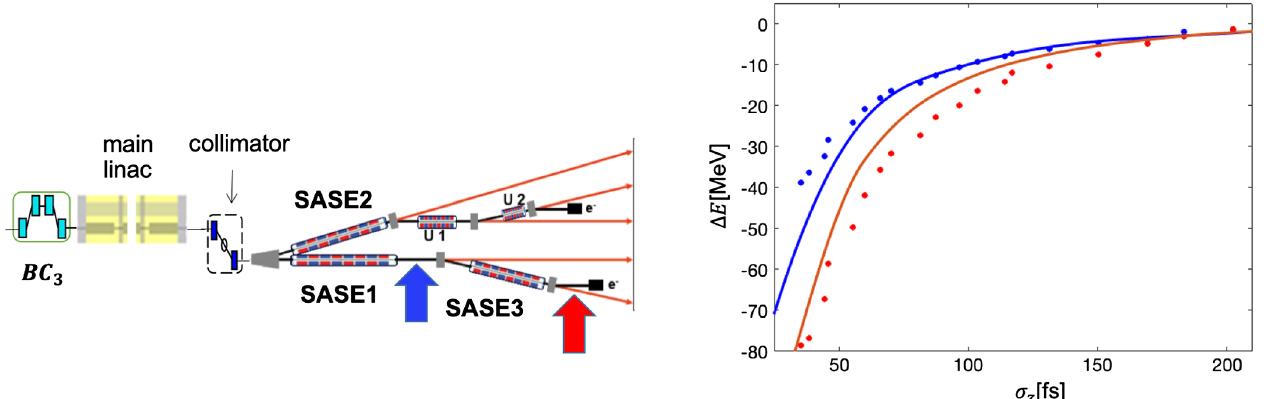
FIG. 15. Comparison of measurements and simulations. The energy loss was measured at two positions shown by arrows in the left plot. The right plot shows the energy loss of the beam for different bunch lengths after BC 3 . The simulation results are shown by solid lines. The measured data are presented by points. The results after SASE1 are shown in blue, and the results after SASE3 are shown in